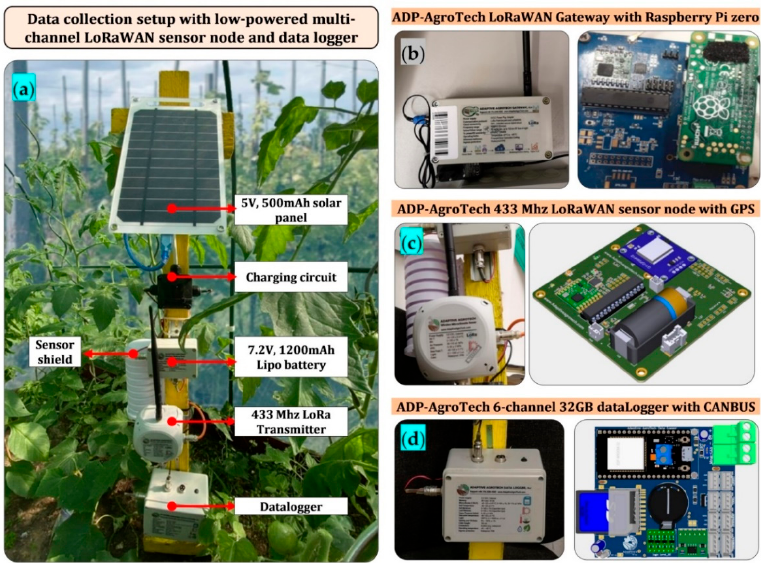
Figure 4. View of the wireless data acquisition system used in the experiment.